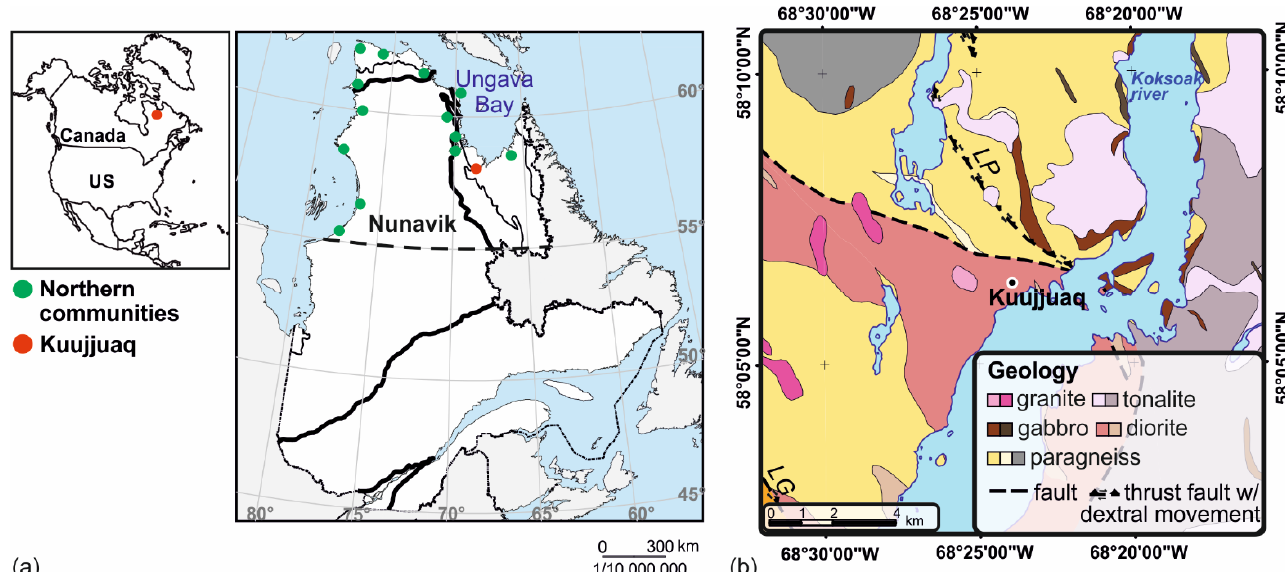
Figure 2. ( a ) Geographical location of Kuujjuaq and the remaining communities in Nunavik; ( b ) geological setting of the study area. LP —Lac Pingiajjulik fault, LG —Lac Gabriel fault. Adapted from SIGÉOM [47] and Miranda et al. [48].